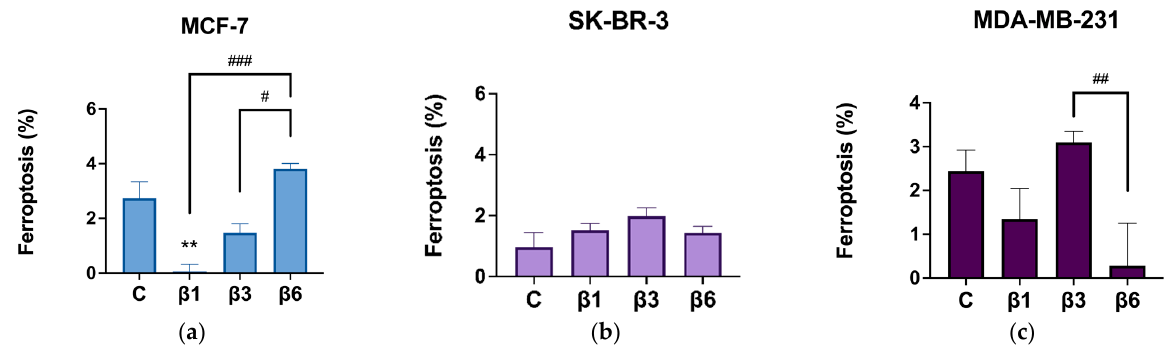
( d ) Figure 2. Percentage of apoptotic cells after treatment with β 1-conglutin (2.5 ng/µL) β 3-conglutin (5 ng/µL) or β 6-conglutin (10 ng/µL) for 24 h in ( a ) MCF-10A, ( b ) MCF-7, ( c ) SK-BR-3, and ( d ) MDA- MB-321. After 24 h of ( a ) β 1, ( b ) β 3, and ( c ) β 6-conglutin treatment, cells were trypsinized, washed, and incubated for 15 min with both AnnexinV-FITC and Propidium Iodide from the IP-Annexin V kit (BD Biosciences, UK). Apoptosis was calculated with both early and late apoptotic cells. Samples were immediately analyzed using the BD FACS Aria IIIu Flow Cytometer (Becton Dickinson, BD Bioscience). * p < 0.05, ** p < 0.01, and *** p < 0.001 vs. non-treated cells, and # p < 0.05, ## p < 0.01, and ### p < 0.001 vs. other treatments. To elucidate if other caspase-independent death mechanisms activated by β -conglu- tins could be ferroptosis, the same experiment was performed by adding Ferrostatin-1 (1 µM), an inhibitor of ferroptosis, to each condition during 24 h (Figure 3). MCF-10A cells were not considered for this experiment as they show no activation of apoptosis under